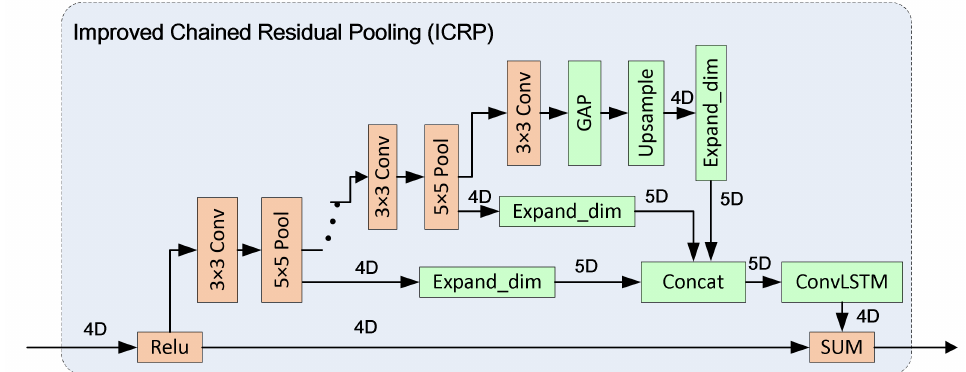
Figure 8. The structure of Improved Chained Residual Pooling (ICRP). 4D and 5D denote 4-dimensional tensor and 5-dimensional tensor